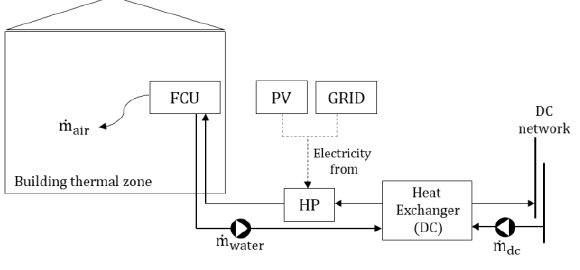
Figure 4. Schematic of the cooling system.